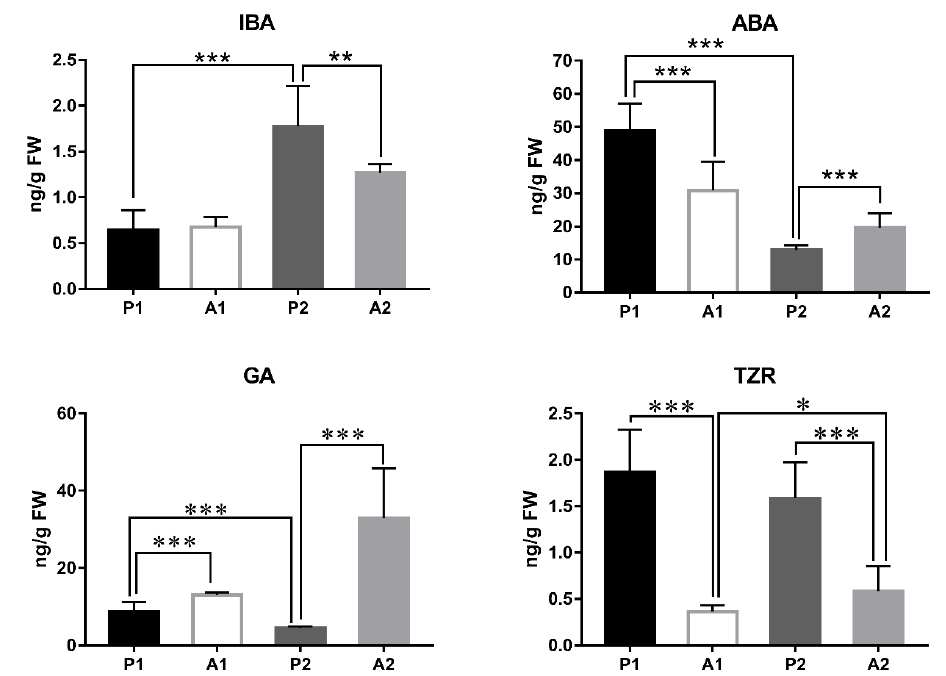
Figure 4. Analysis of plant hormone content in abscised and persisting fruitlets at 35 and 48 DAA. P1, persisting fruitlets at 35 DAA; P2, persisting fruitlets at 48 DAA; A1, abscised fruitlets at 35 DAA; A2, abscised fruitlets at 48 DAA. Statistically significant differences were calculated with GraphPad Prism 7.00. Data represent average ± SD of three biological repeats with three measurements. * Significant differences at p < 0.05; ** significant differences at p < 0.01; *** significant differences at p < 0.001.